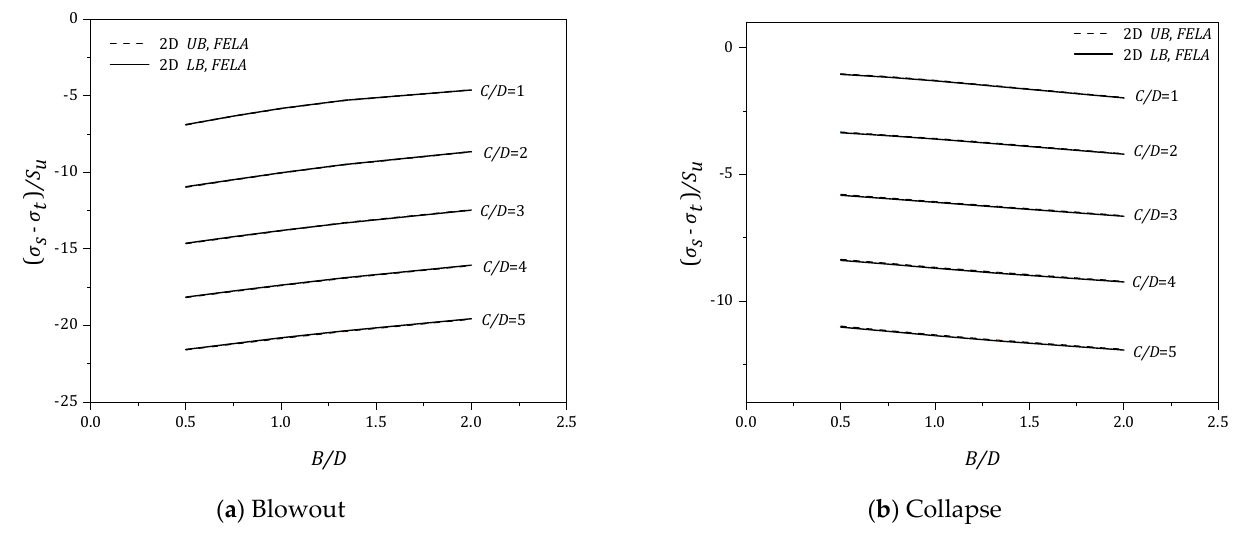
Figure 7. ( σ s − σ t )/S u vs ( B/D ) for various ( C/D) − γ D/S u = 3. Using the same data, the effects of ( C/D ) are presented in Figures 8–12. In general, for i.e., ( σ s ) must be greater than ( σ t ) to cause a collapse. Numerical results in Figure